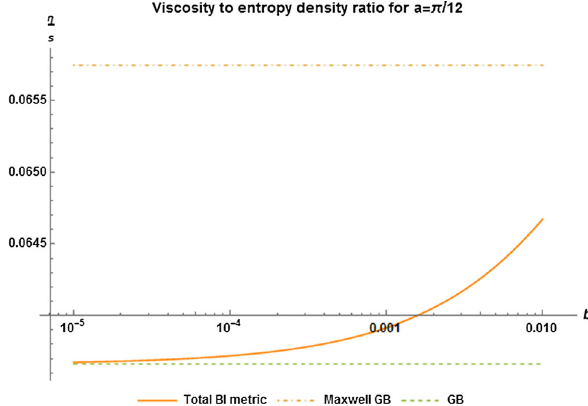
Fig. 4 Viscosity to entropy ratio in large charge